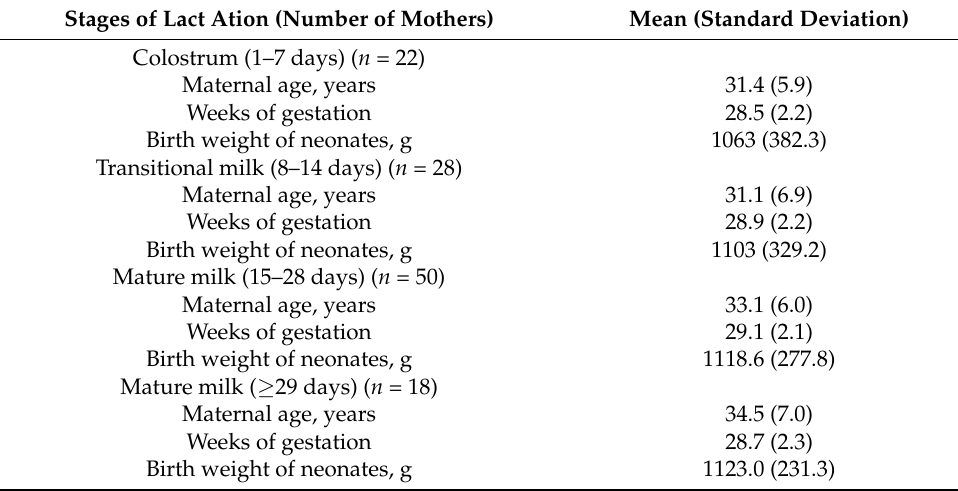
Table 1. Characteristics of mothers and neonates included in the study. Stages of Lact Ation (Number of Mothers) Mean (Standard Deviation) Colostrum (1–7 days) ( n =